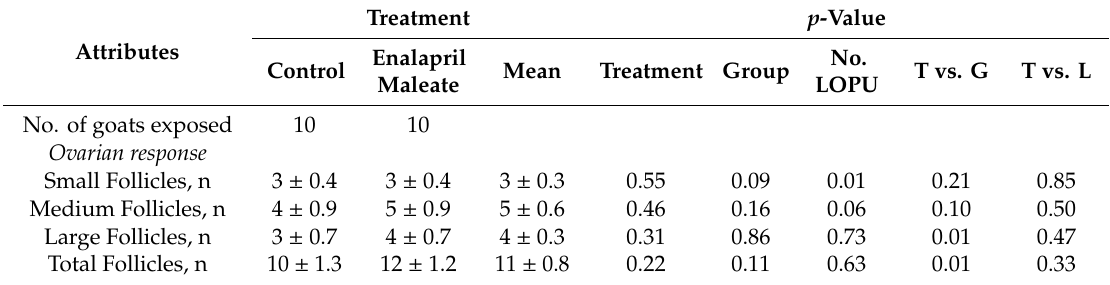
Table 1. Ovarian response from Nulliparous and Multiparous hormonal stimulated goats treated with enalapril maleate. Values are expressed as mean ± standard error of the mean.